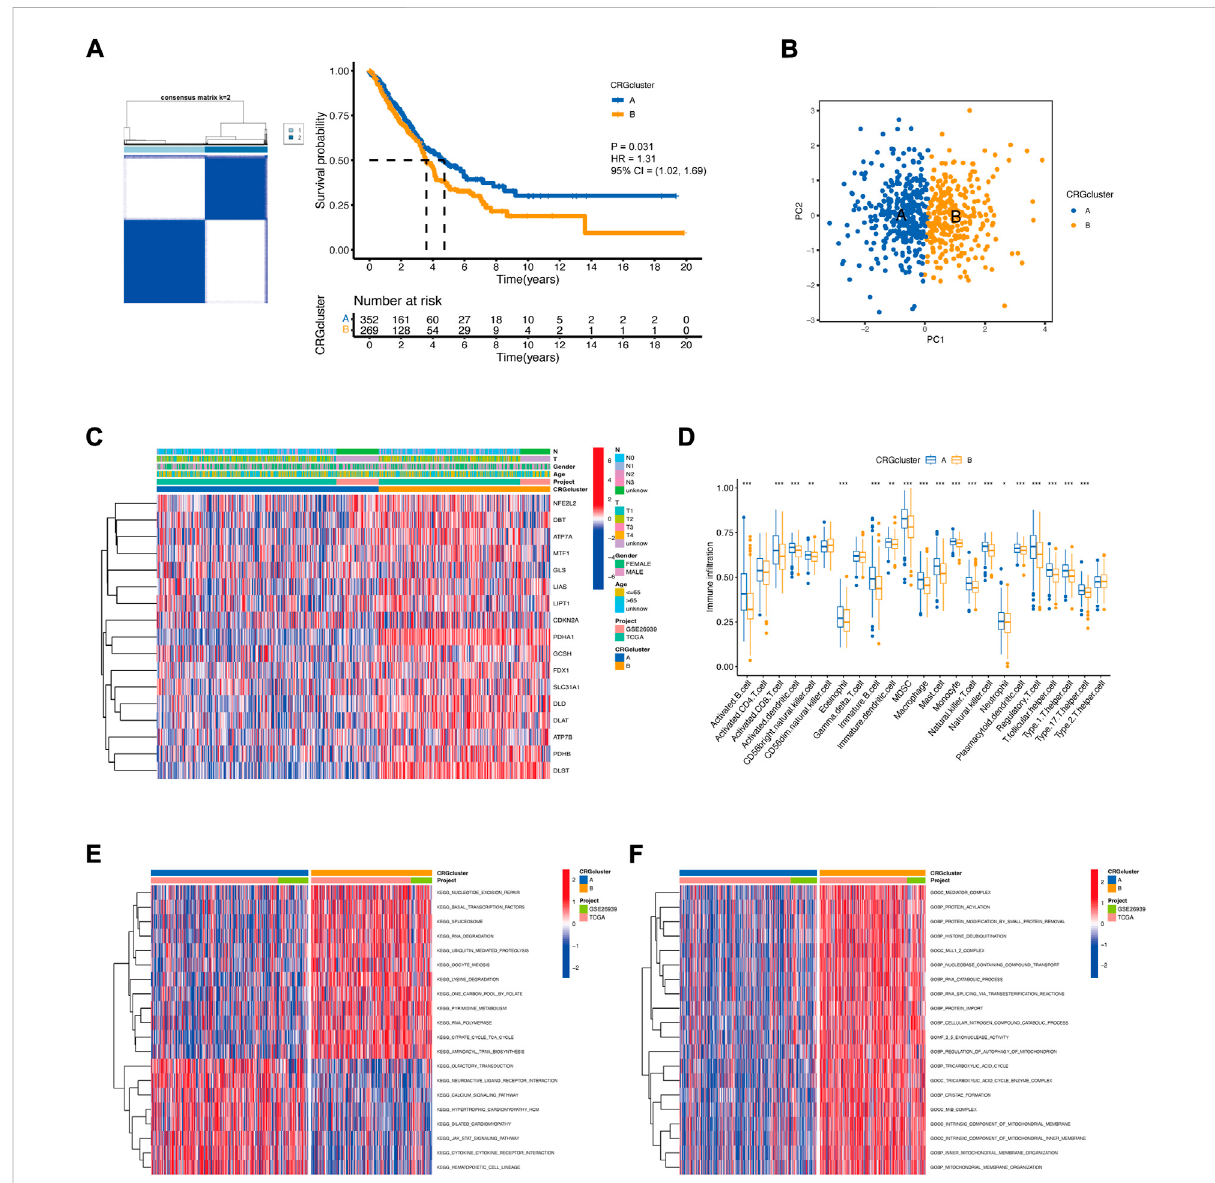
FIGURE 3 The landscape of the cuproptosis and the biological characteristics of the cuproptosis subtypes in LUAD. (A) Clustering of patients with LUAD based on PDHA1 and DLAT expression. Consensus clustering matrix for k = 2. Kaplan − Meier plot of the CRG clusters and overall survival probability. (B) PCA of two cuproptosis subtypes. (C) Relationship between the cuproptosis subtypes and various clinical characteristics. (D) TME-in fi ltrating cell composition between the two cuproptosis subtypes (Wilcoxon test; * p < 0.05; ** p < 0.01; *** p < 0.001). (E,F) Functional and biological differences between the cuproptosis